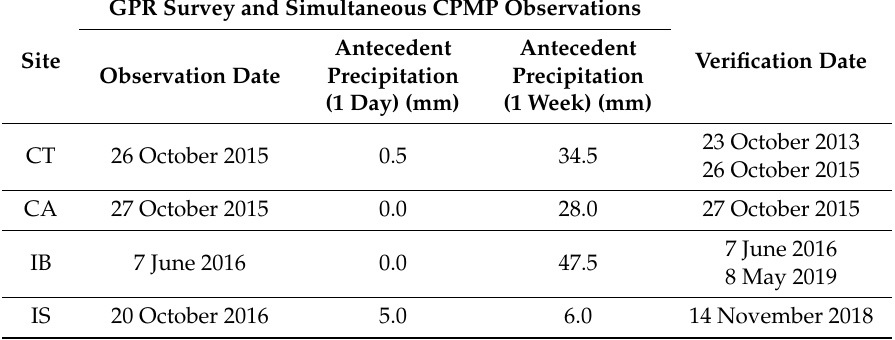
Table 1. Dates of the ground-penetrating radar (GPR) survey and combined penetrometer–moisture probe (CPMP) observations alongside antecedent precipitation data at each study site. The final column lists the associated date on which the volumetric soil water content ( θ ) was